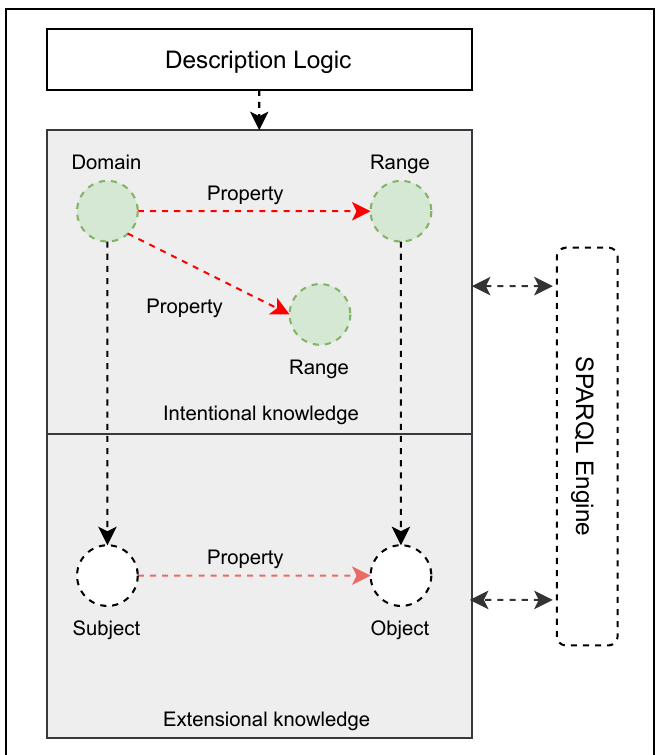
Figure 2. Semantic DL ontology